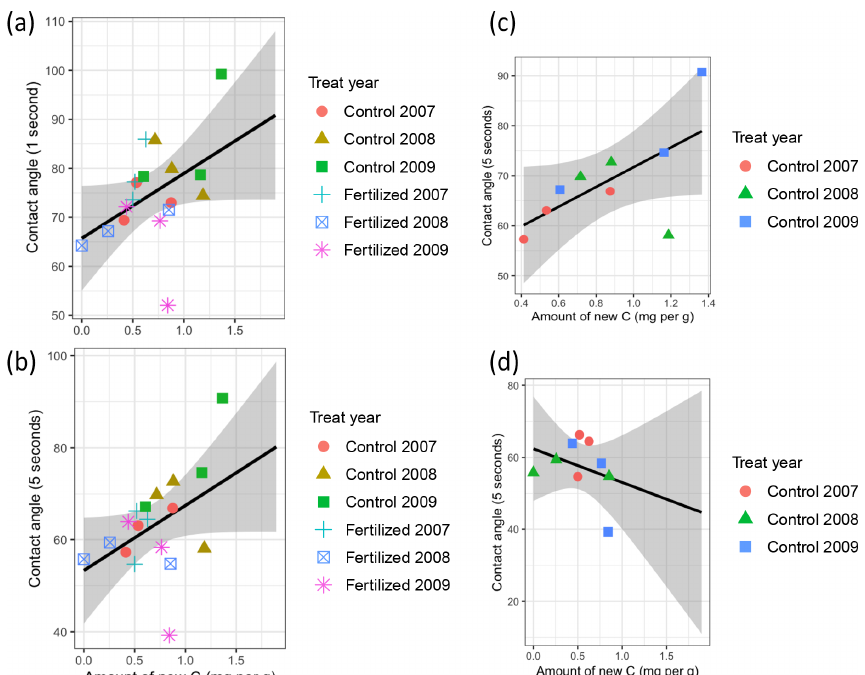
Figure 2. Correlation between the amount of new C and the hydrophobicity of the mesh bag contents measured as the contact angle (CA). The CA was determined directly after placement of the water drop at (a) 1s and (b) 5s. (c) Correlation between the amount of new C and the hydrophobicity of the mesh bag at 5s in the control plots. (d) Correlation between the amount of new C and the hydrophobicity of the mesh bag at 5s in the fertilized